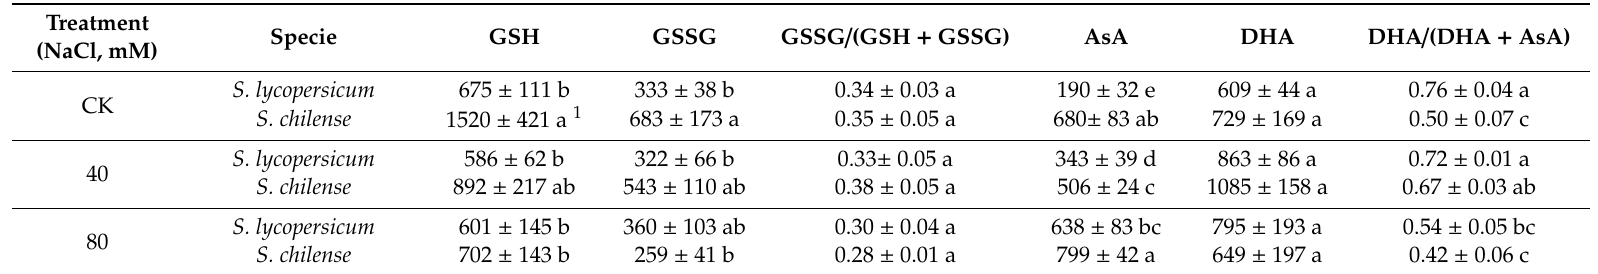
Table 2. Antioxidants (reduced (GSH) and oxidized glutathione (GSSG)) in nmol g − 1 FW; ascorbate (AsA) and dehydroascorbate (DHA) in nmol g − 1 FW in fruits of two tomato species (cultivated Cherry tomato Solanum lycopersicum , and halophyte wild-relative S. chilense ) under saline stress conditions at the end of experimental period (112 days). Each value represents mean ± SE ( n =